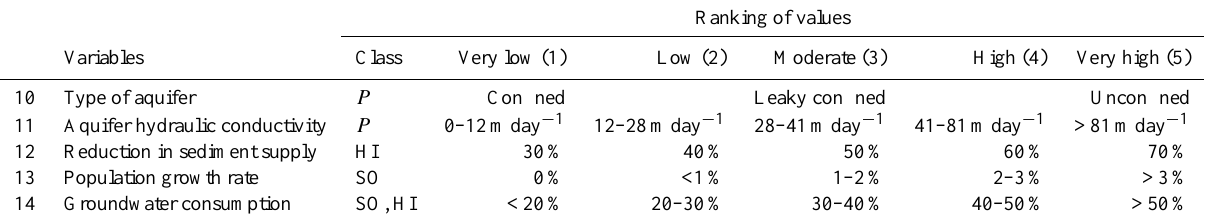
Table 3. Data range and ranking of the susceptibility CV SLR I variables.